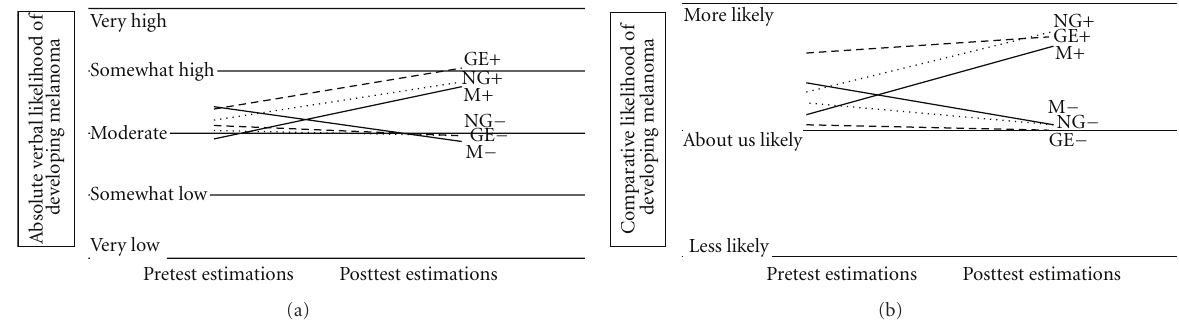
Figure 1: Changes in melanoma risk perceptions (Pretest-posttest). (a) Absolute verbal likelihood. How likely is it that you will develop melanoma in the future? Would you say your chance of getting melanoma is ... ? (b) Comparative likelihood. Compared to the average person your age, would you say that you are more, less, or about as likely to develop melanoma? GE (gene environment), NG (nongenetic), and M (mutation) are denoted according to feedback, positive or negative